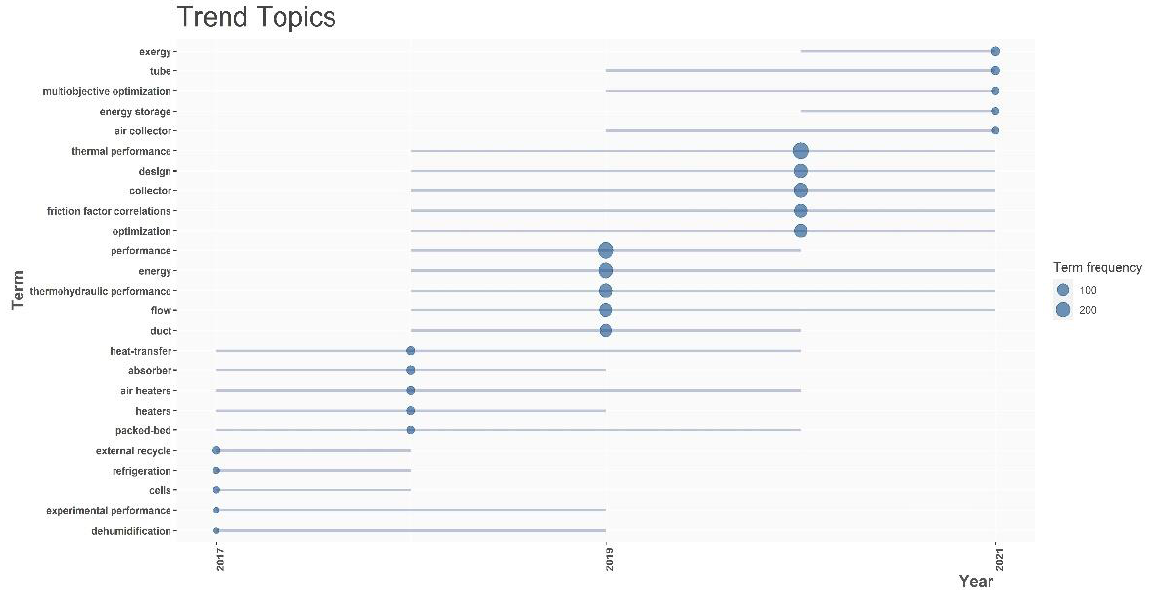
Figure 7. Research trend topics during 2017 – 2021 for solar air heater domain.